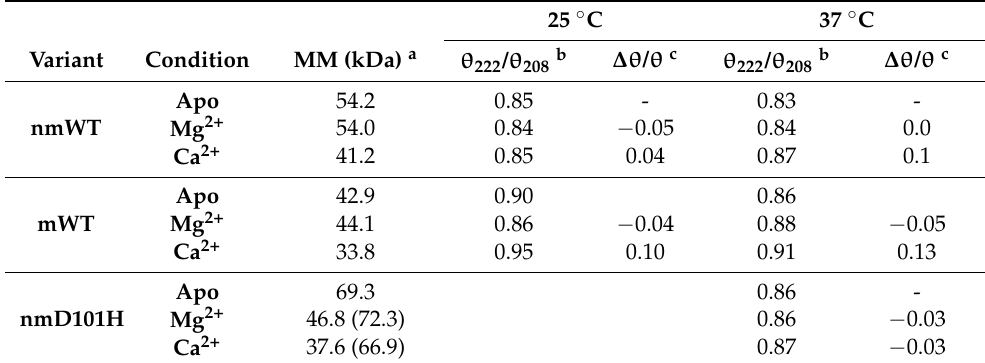
Figure 4. Analytical SEC chromatograms of ~40 µ M ( A ) nmWT, ( B ) mWT and ( C ) nmD101H GCAP3 in the presence of 500 µ M EGTA (black), 500 µ M EGTA and 1 mM Mg 2+ (blue), or 1 mM Mg 2+ and 500 µ M Ca 2+ (red). Table 1. Results from Analytical SEC and CD